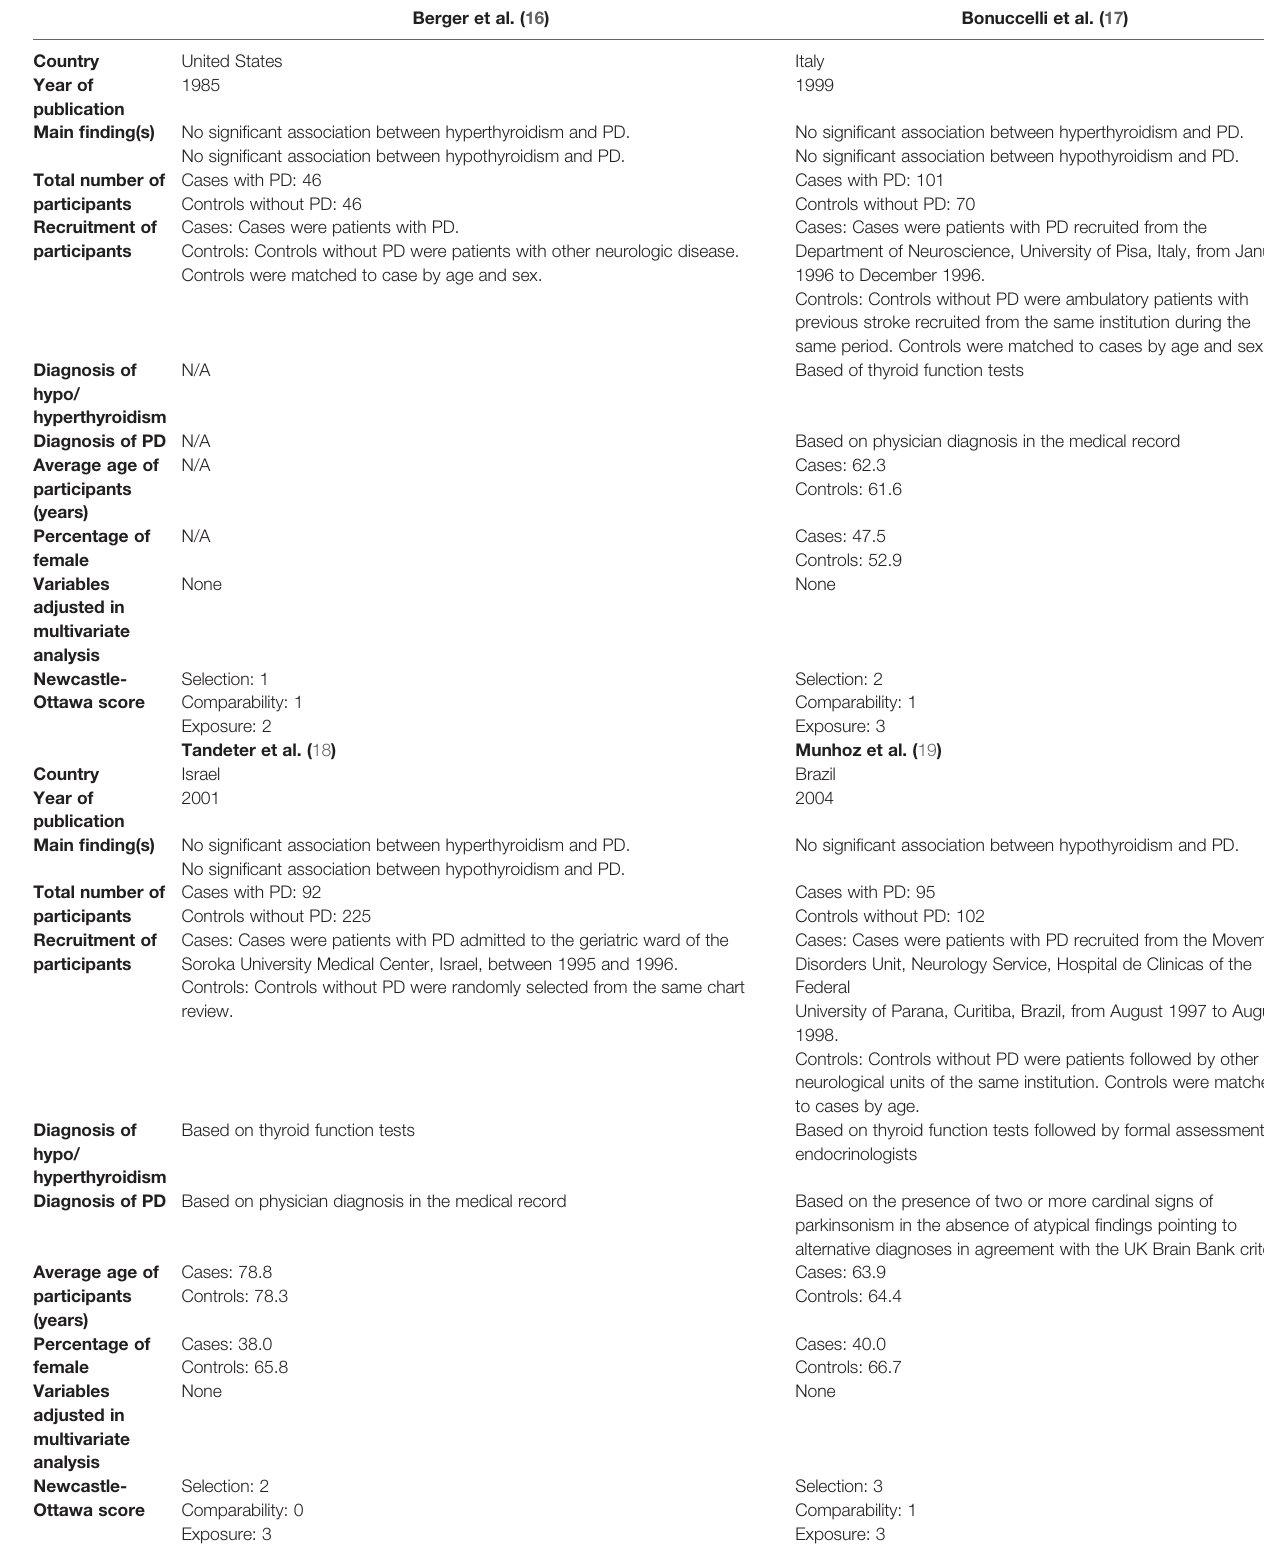
TABLE 2 | Main characteristics of the case-control studies included in the